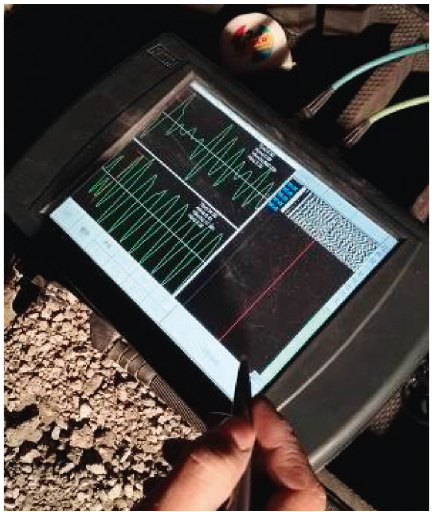
Figure 3: The RSM-SY6 acoustic wave